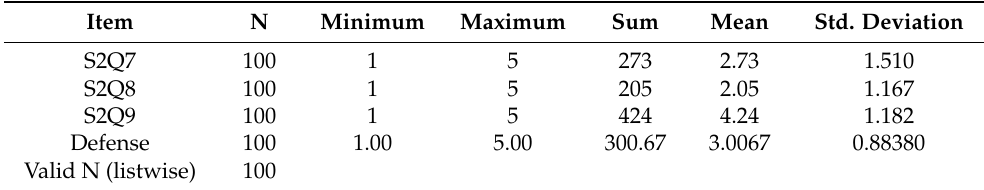
Table 3. Descriptive statistics of perception of Defense stage.